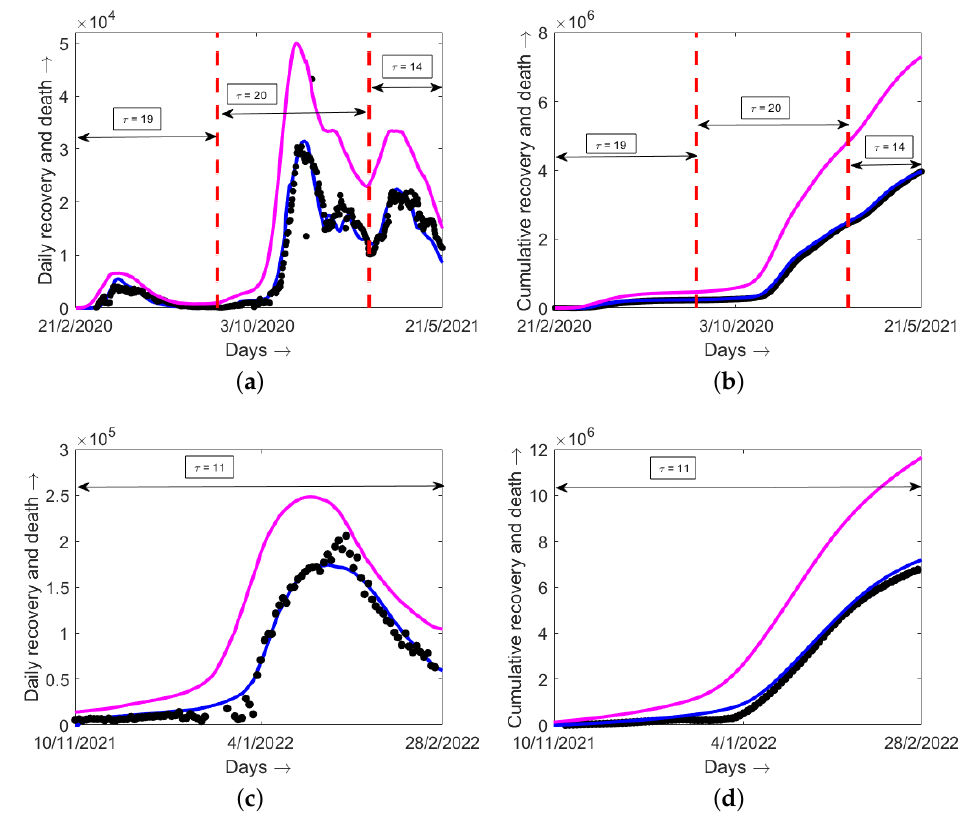
Figure 7. The blue curves show the number Σ ( t ) of recovered and dead in the delay model; the ma- genta curves correspond to σ ( t ) in the SIR model; the black dots correspond to the 7-day moving average of daily recoveries and death in